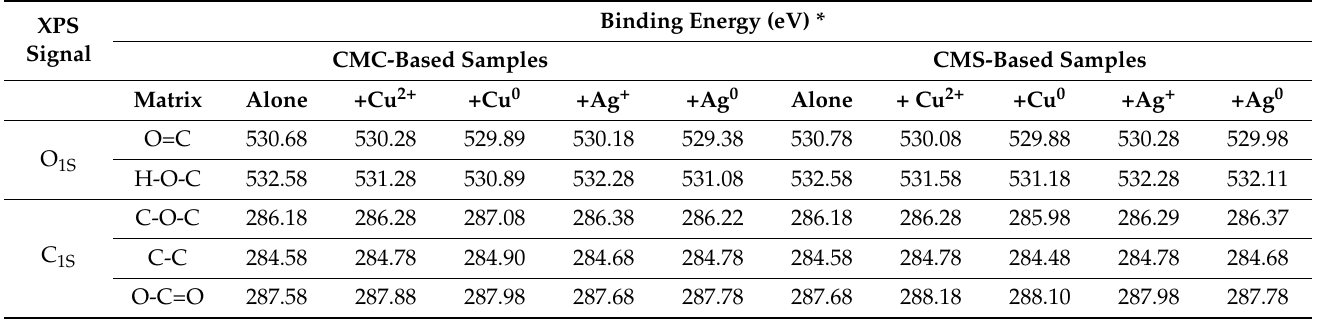
Table 2. Binding energy (eV) for key elements in the synthesized